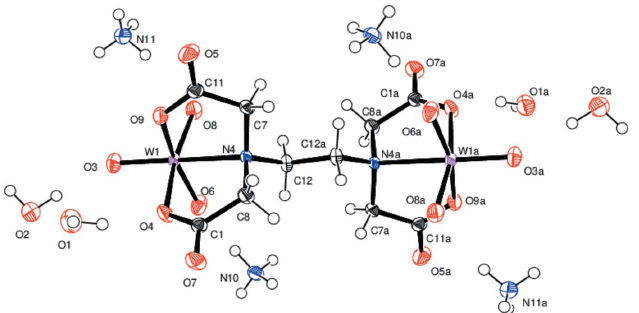
Figure 1 Molecular structure of the title compound. Displacement ellipsoids are drawn at the 50% probability level.